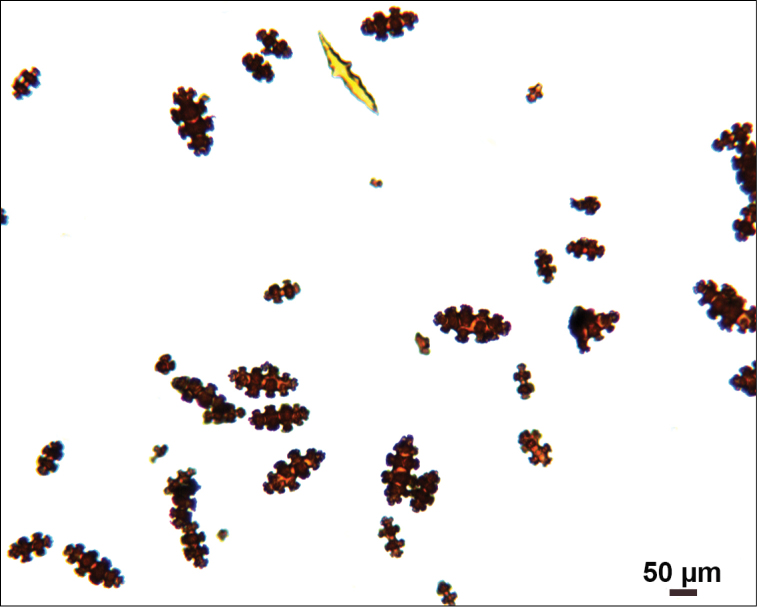
Leptogorgiadiffusa, SBMNH 423090, light microscopy, 10×, showing sclerites typical of genus and this species. Note pale yellow anthocodial sclerite, upper middle portion of field, amongst deep red to mauve-pink spindles. Longest sclerites may be part of the anthocodial armature.